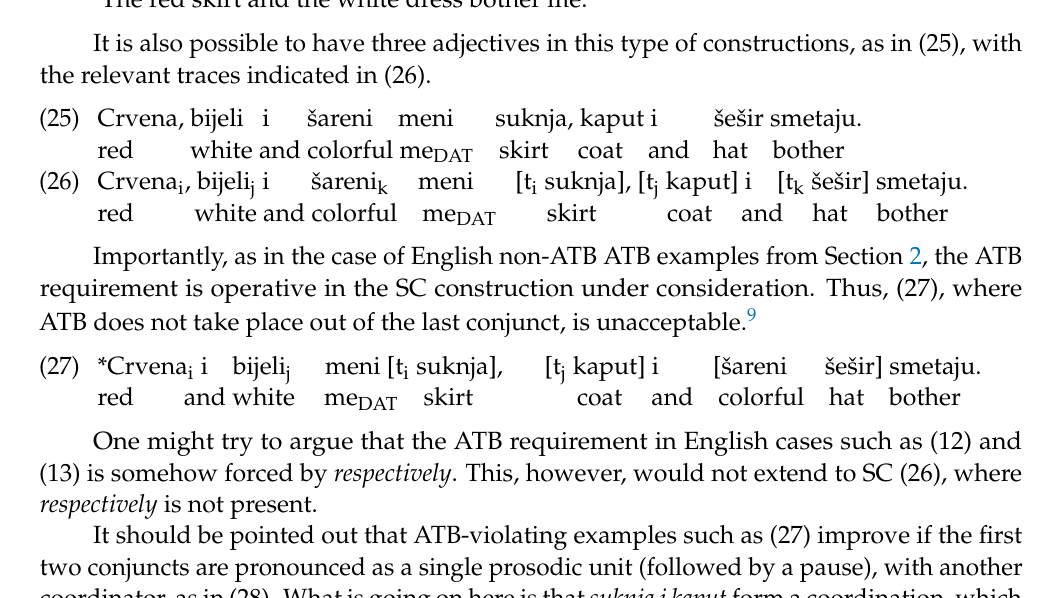
skirt and dress bother